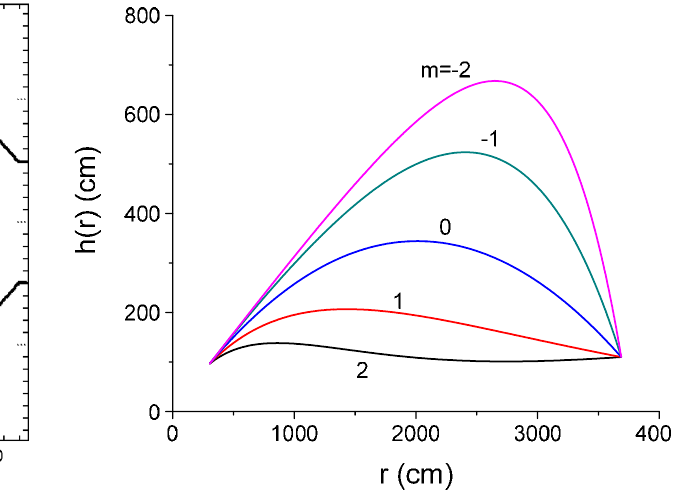
FIG. 4. (Color) Gap profiles h (cid:3) r (cid:4) as a function of r for trans- former design I and several values of the gap parameter m